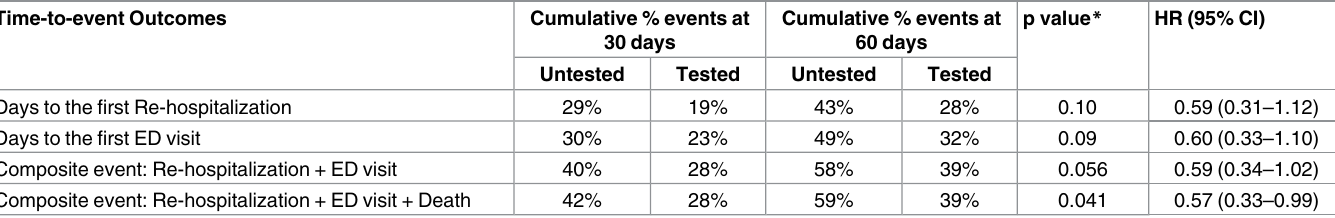
Table 4. Comparison of the time-to-event outcomes between the untested and tested groups. Time-to-event